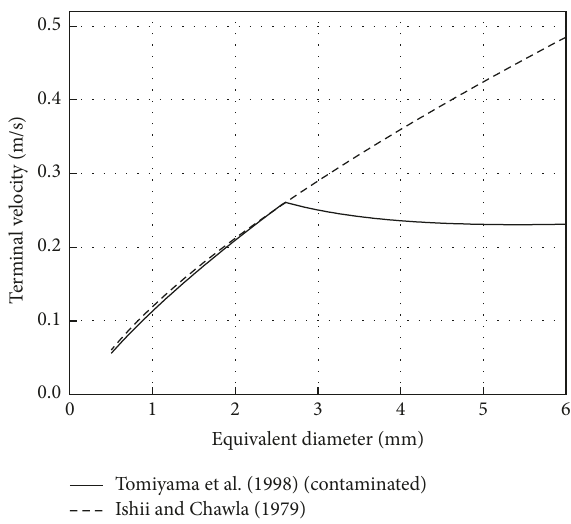
Figure 5: Terminal velocity for Tomiyama et al. [4] and Ishii and Chawla [5] drag